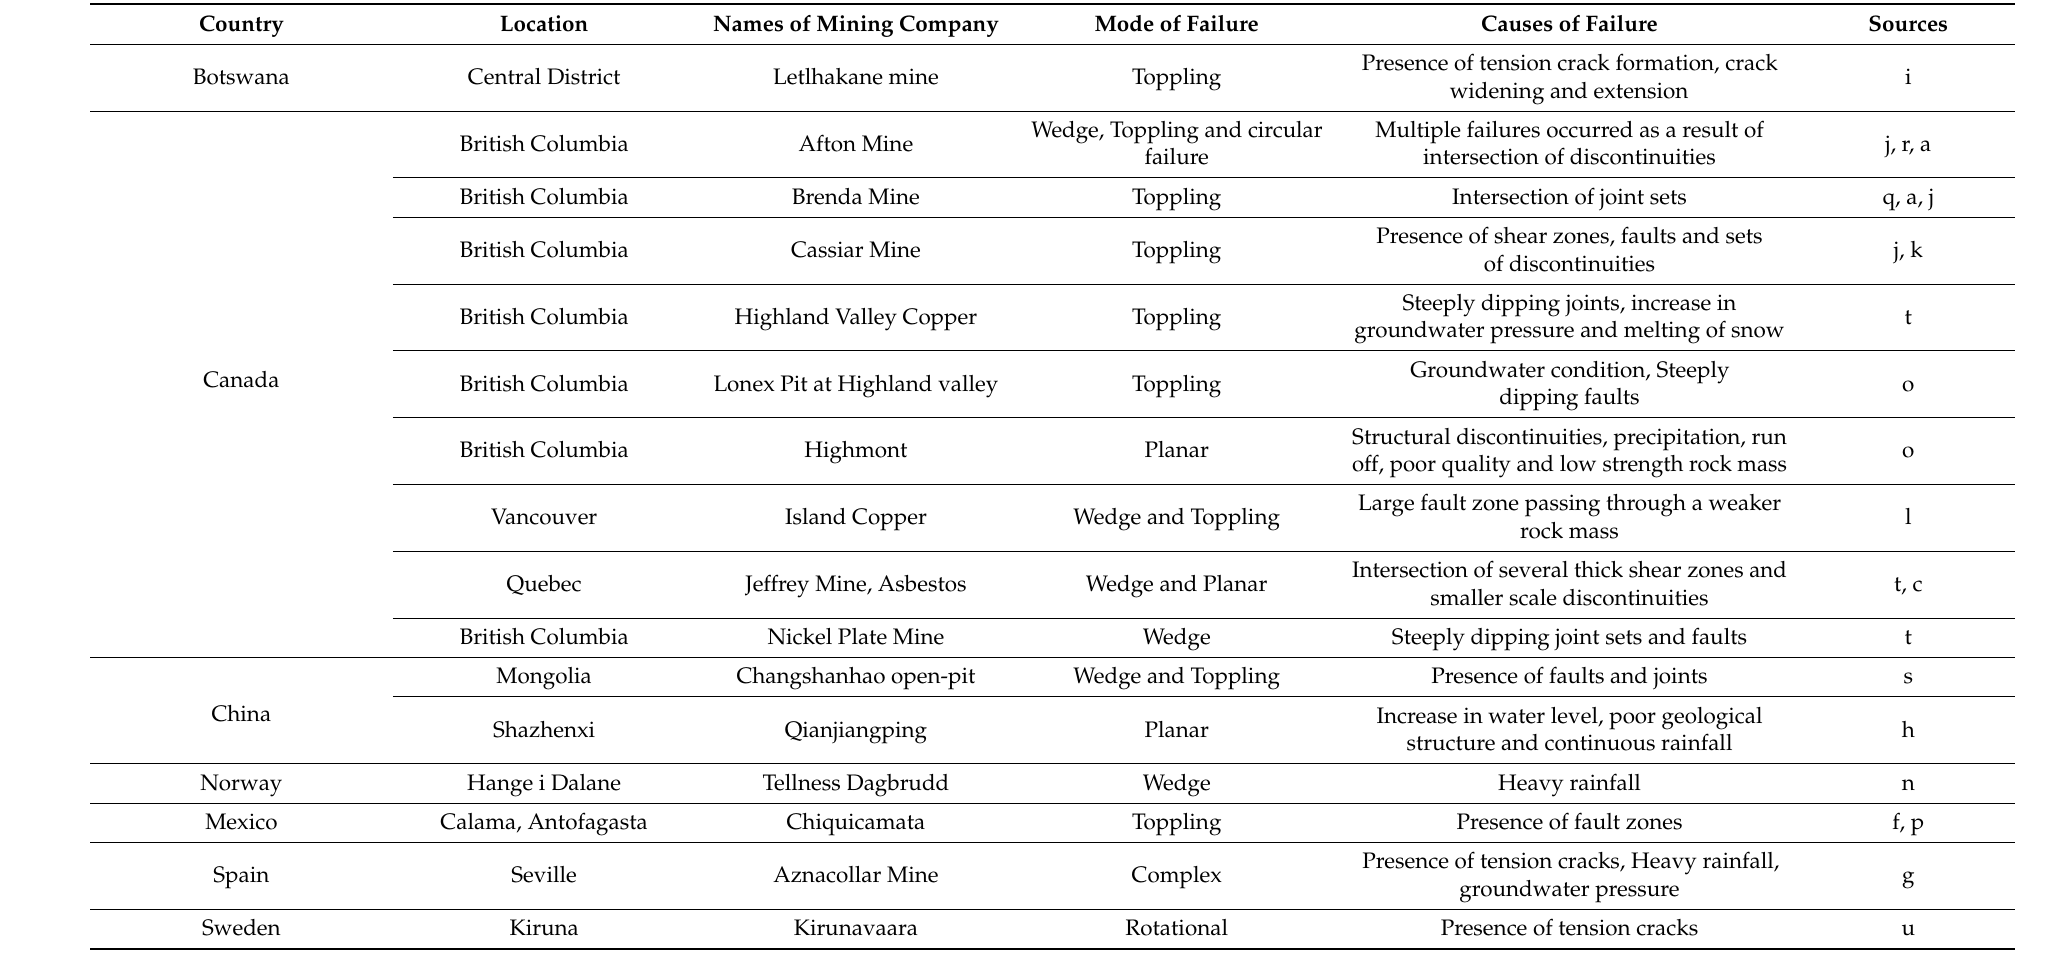
Table 3. List of failed mine